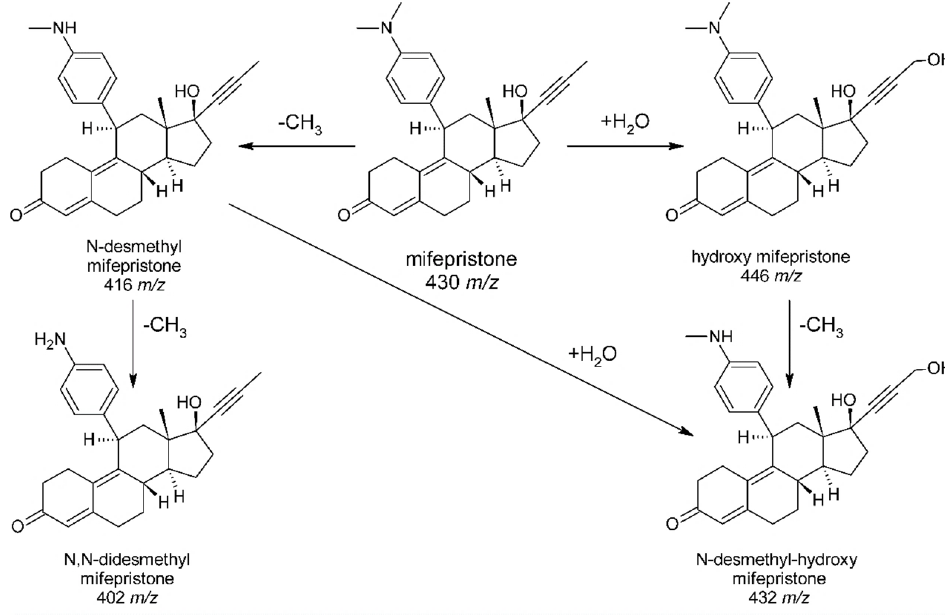
Figure 2. Proposed metabolism of mifepristone (RU-486) in humans.